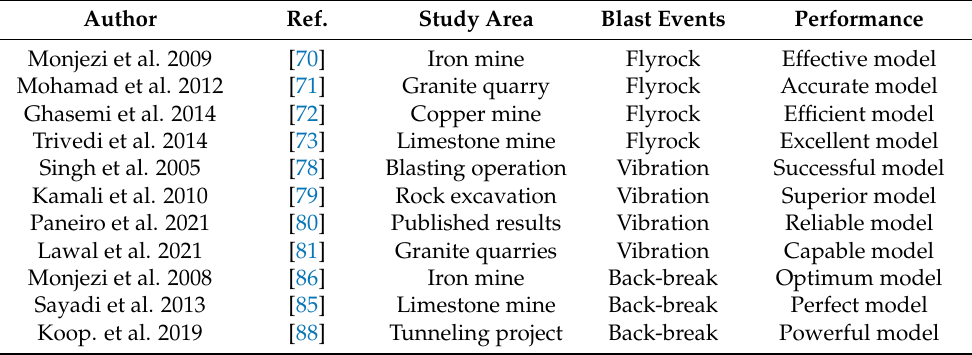
Table 7. Summary of some artificial neural network applications in the prediction of blasting- induced